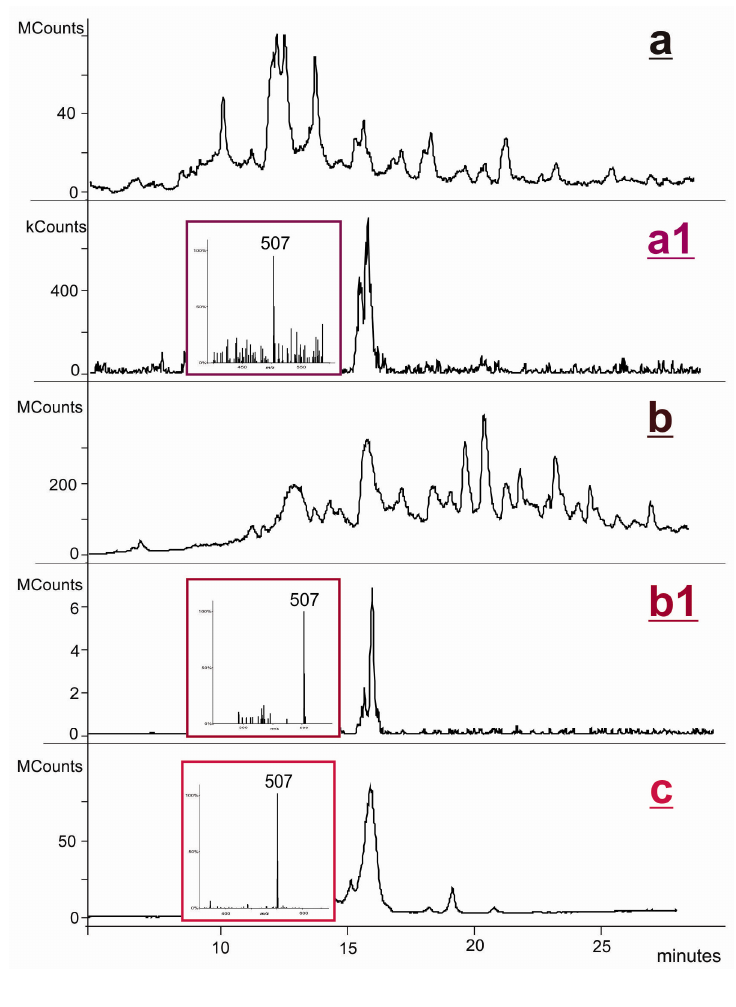
Figure 5. Analysis of the enzymatic hydrolysate of NVP-modified DNA, obtained upon reaction of 12-mesyloxy-NVP ( 6 ) with salmon testis DNA and subsequent enzymatic hydrolysis to 2'-deoxynucleosides: ( a ) HPLC-ESI-MS total ion chromatogram; ( a1 ) extracted ion chromatogram and mass spectrum of the m/z 507 ion. Analysis of the reaction mixture obtained upon reaction of 12-mesyloxy-NVP ( 6 ) with dT: ( b ) HPLC-ESI-MS total ion chromatogram; ( b1 ) extracted ion chromatogram and mass spectrum of the m/z 507 ion. Analysis of the synthetic standard, N3-NVP-dT ( 9 ): ( c ) HPLC-ESI-MS total ion chromatogram and mass spectrum of the m/z 507